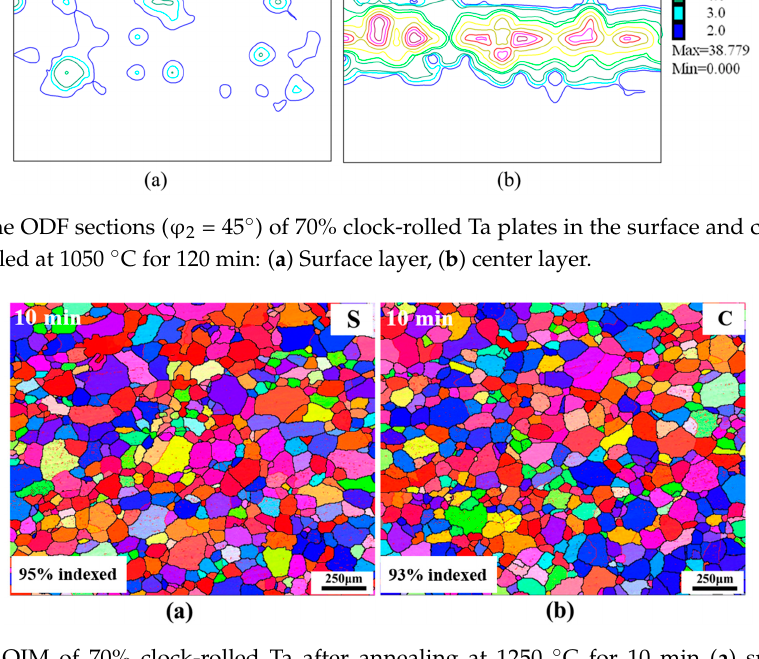
Figure 9. The ODF sections ( φ 2 = 45°) of 70% clock-rolled Ta plates in the surface and center layers when annealed at 1050 °C for 120 min: ( a ) Surface layer, ( b ) center layer.